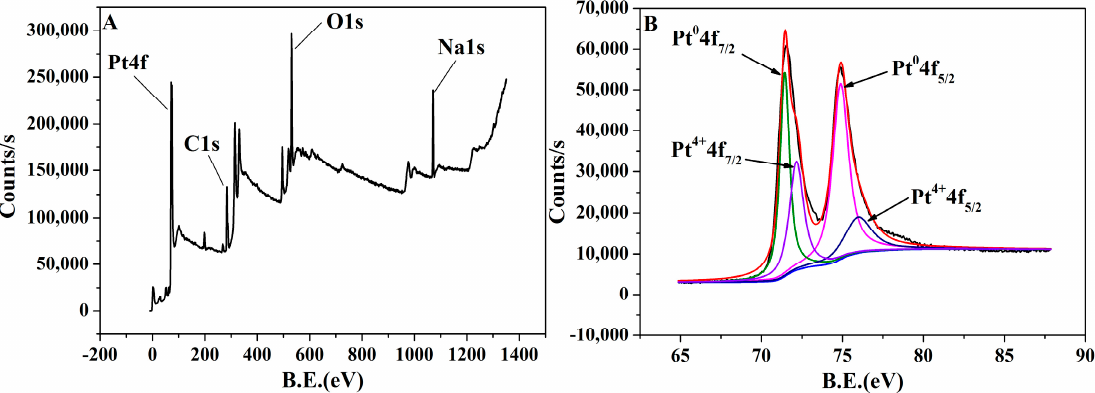
Figure 2. ( A ) The whole XPS spectrum of citrate-modified PtNPs; and ( B ) XPS spectrum showing the binding energy of Pt 4f.